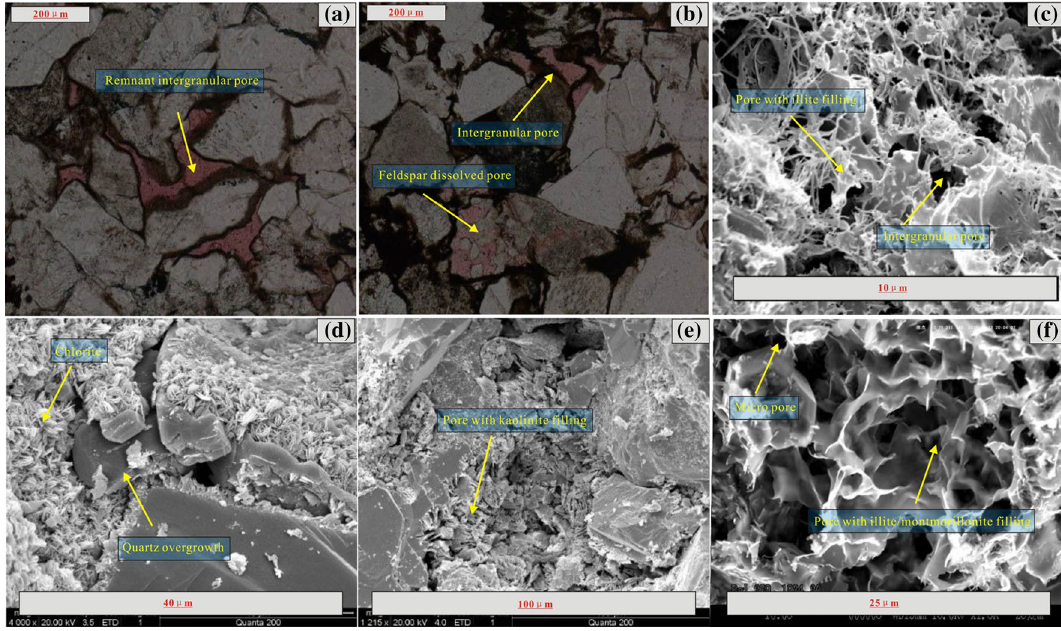
Fig. 4 Characteristics of pore structures and clay mineral contents in the casting thin sections and SEM sections. a Well L98, 2467.18 m, residual intergranular pore; b Well L126, 2163.94 m, feldspar disso-